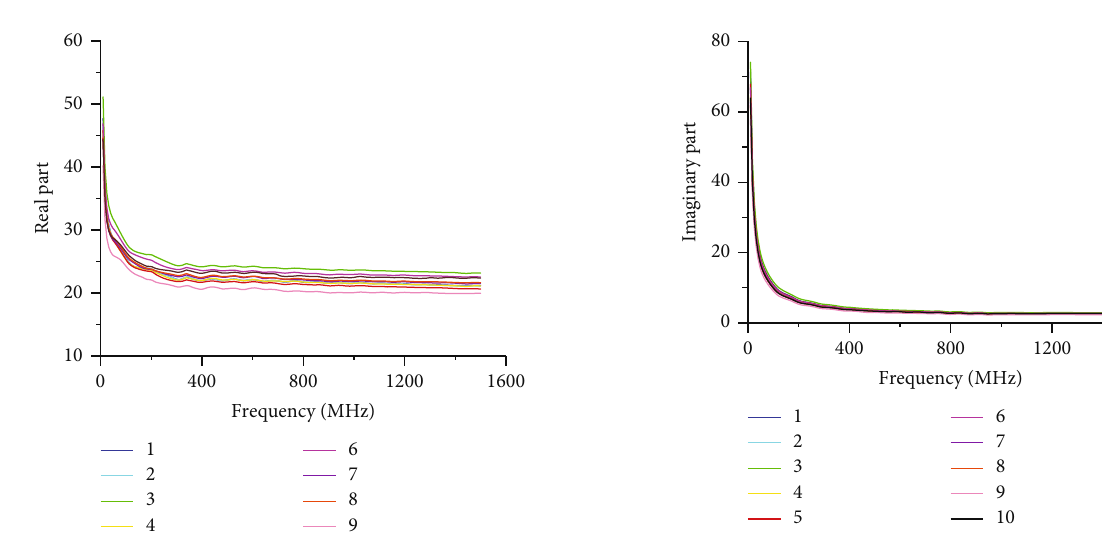
Figure 5: The imaginary part of sample #5 dielectric permittivity changing with frequency under 10 repeated measurements.